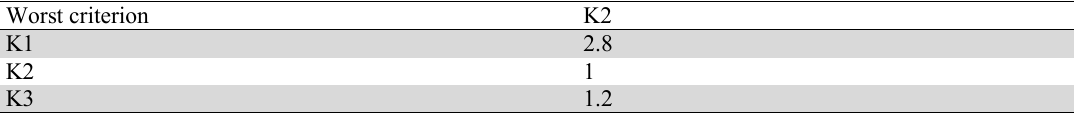
Criteria OW Vector Worst criterion